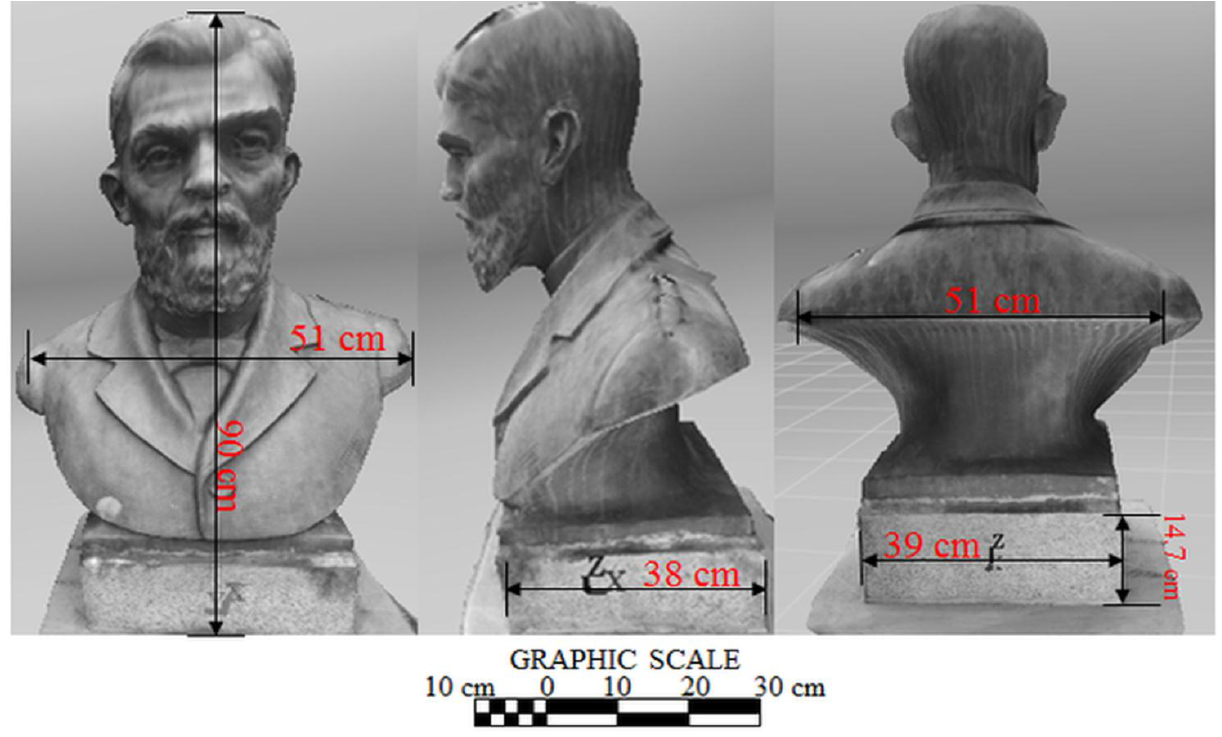
Figure 6. Prudente de Morais